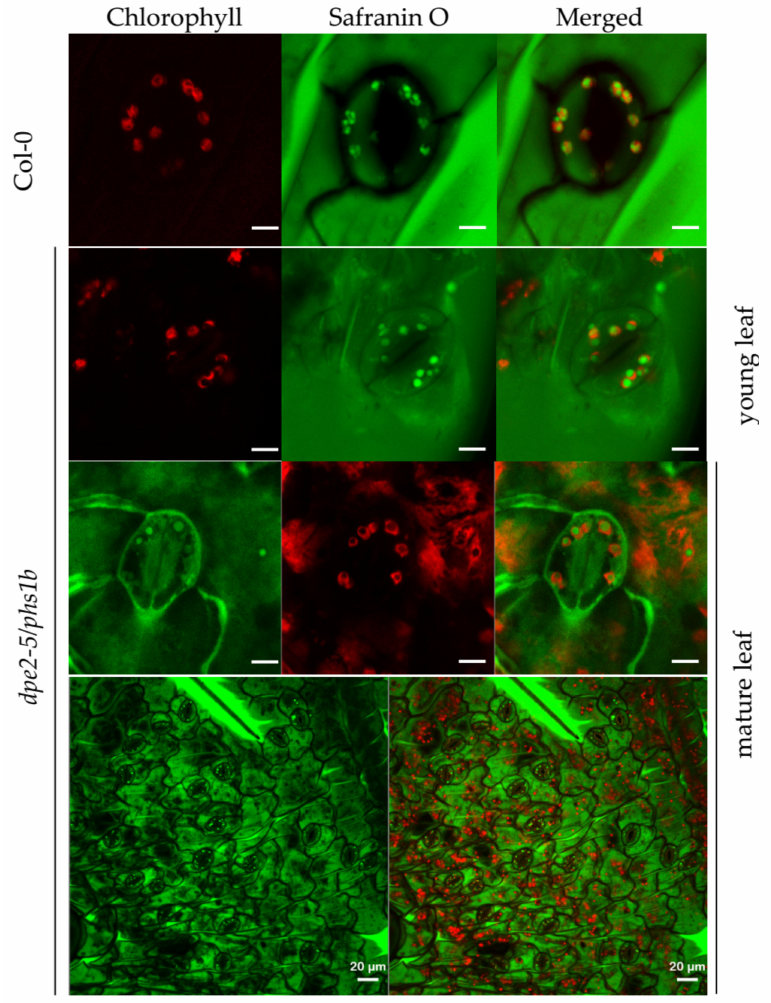
Figure 5. Starch granules in the guard cells of Col-0 and young and mature dpe2-5/phs1b leaves. All pictures were captured from 5-week-old plants in the middle of the daytime. Scale bars are equivalent to 5 and 20 µ